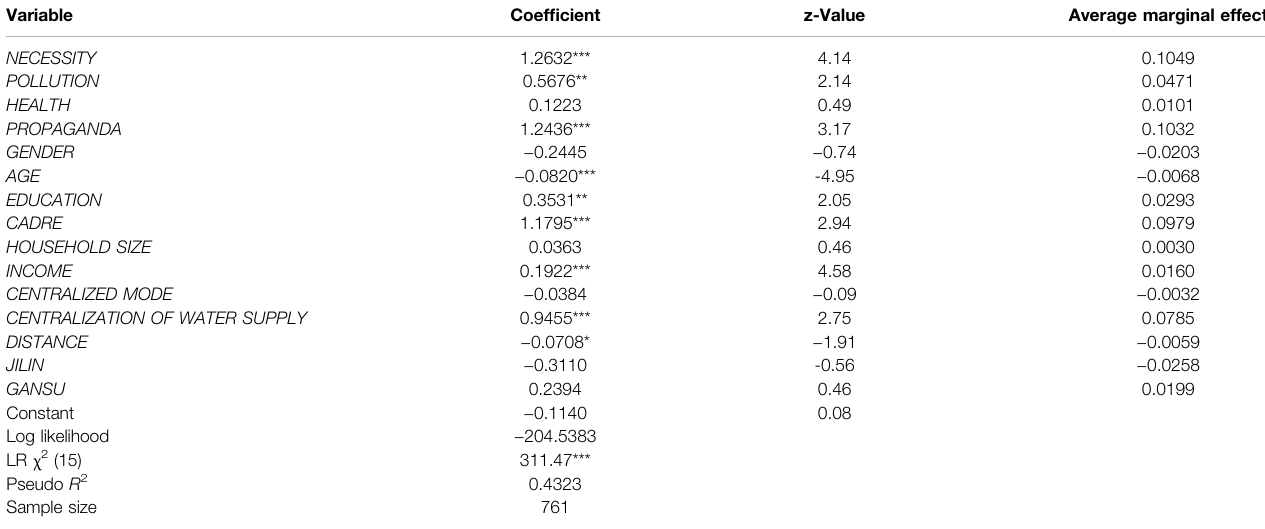
TABLE 3 | Regression results for the farmers ’ WTPP for the CMP of